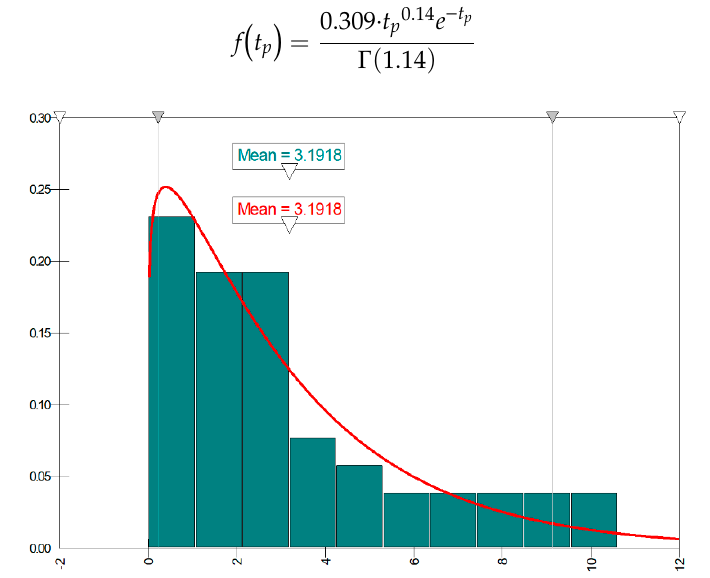
Figure 3. Satellite call process times [min].